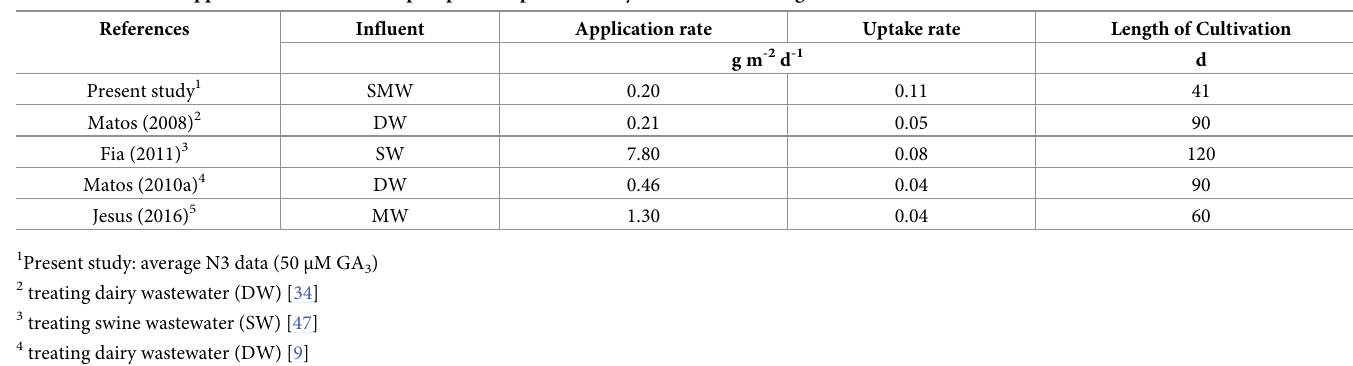
Table 12. Review of application rates and total phosphorus uptake rates by Tifton 85 bermudagrass in